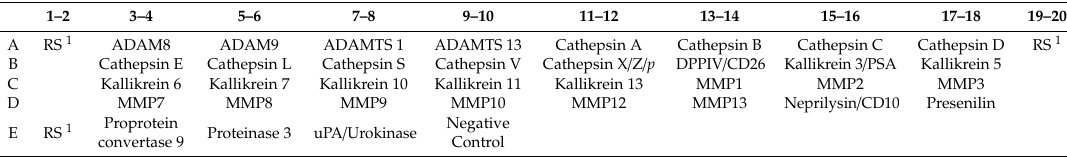
Table 2. Human protease array membrane